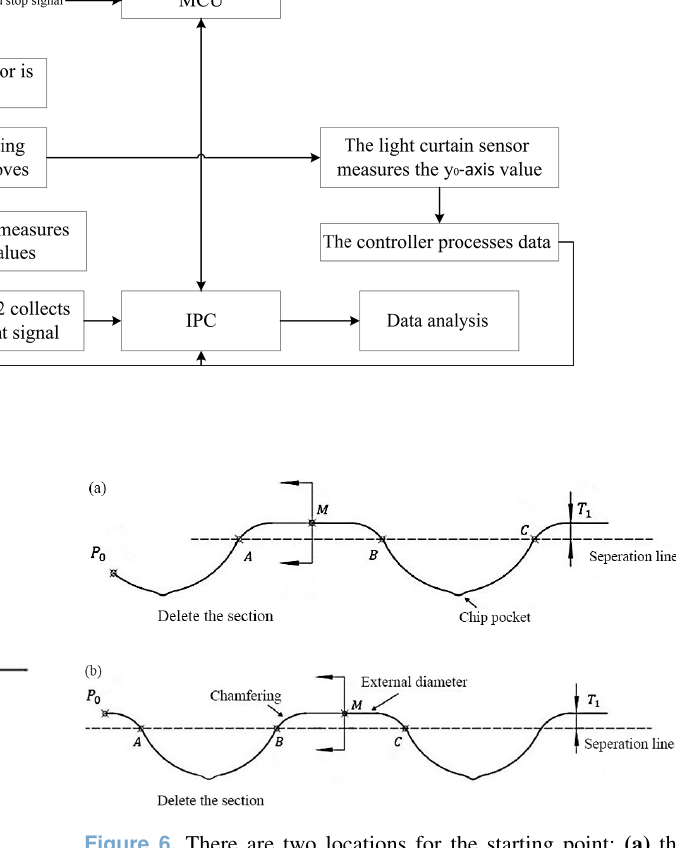
Figure 5. Double arc thread profile.